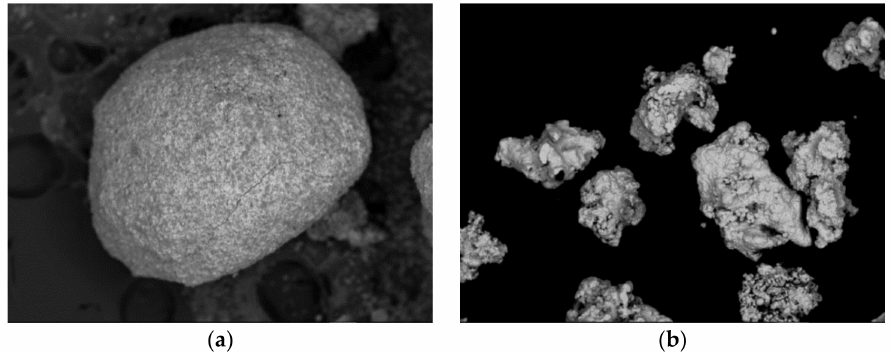
Figure 6. Scanning electron microscopy (SEM) images of MgO_nZVI ( a ) and of commercial mZVI particles ( b